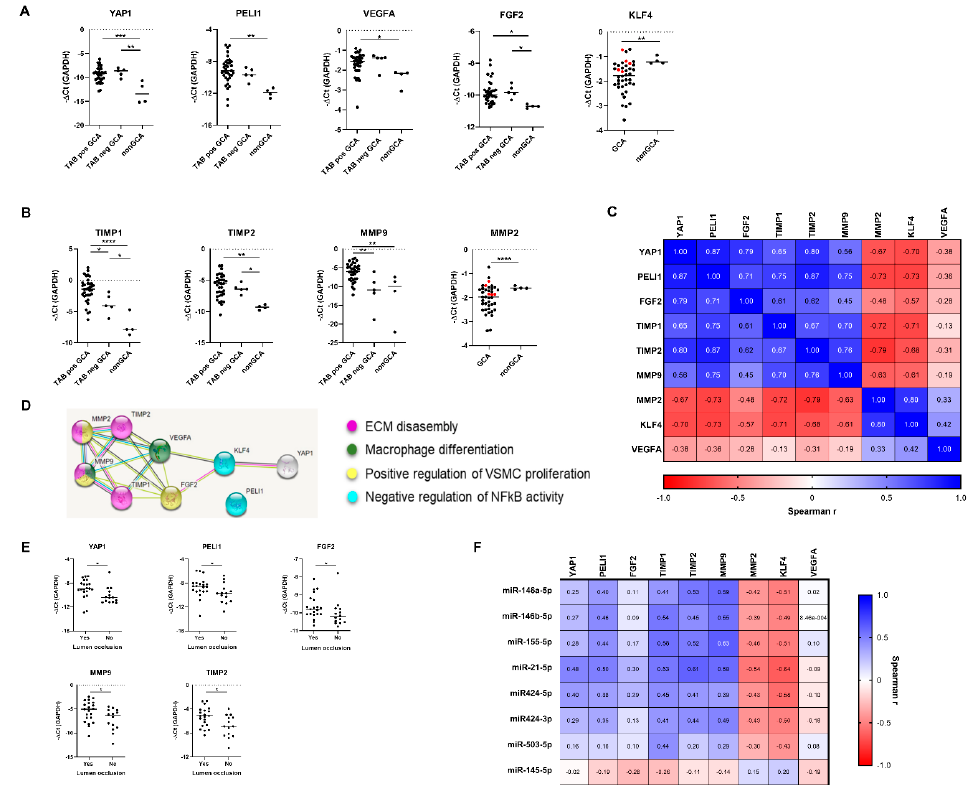
Figure 2. Deregulated miR expression in TABs from GCA patients. ( A ) Differentially expressed miRs in GCA patients with histologically positive TABs ( n = 35), GCA patients with histologically negative TABs ( n = 6) and TABs from nonGCA subjects ( n = 4). miR expression was calculated as negative delta Ct ( − ∆ Ct) of individual miRs normalized to RNU48 expression. Line represents the median miR expression in each patient group. ( B ) Correlation between normalized expression of miR-424-3p, -424-5p and -503-5p in TABs from GCA and nonGCA patients. ( C ) Matrix of Spearman’s rank correlation coefficients between normalized miR expression across GCA ( n = 41) and nonGCA ( n = 4) TABs. Plotted are miRs that were identified as deregulated in GCA TABs. p values of the correlations are provided in the Supplementary Table S1. ( D ) Normalized expression of miR-146a-5p in histologically positive GCA TABs with or without temporal artery lumen occlusion. ( E ) Matrix of Spearman’s rank correlation coefficients between normalized miR expression and sonographic measurements of the temporal arterial thickness in 41 GCA patients. Plotted are miRs that were identified as deregulated in GCA TABs. ( F ) Matrix of Spearman’s rank correlation coefficients between normalized miR expression and systemic inflammation markers in 35 GCA patients with histologically positive TABs. Plotted are miRs that were identified as deregulated in GCA TABs. p -value of <0.05 was considered as statistically significant. * p < 0.05; ** p < 0.01; *** p < 0.001; **** p < 0.0001. Legend: CRP, C-reactive protein; ESR, erythrocyte sedimentation rate; GCA, giant cell arteritis; HB, heamoglobin; miR, microRNA; PCT, procalcitonin; SAA, serum amyloid A; TAB, temporal artery